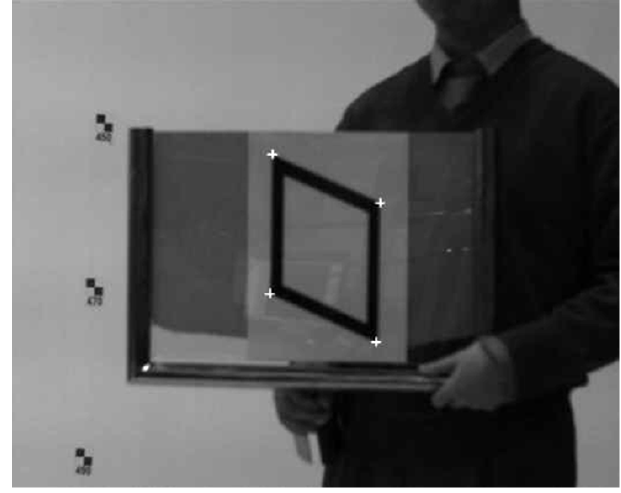
Figure 5. Experimental images for measuring a parallelogram object’ pose and shape parameters.